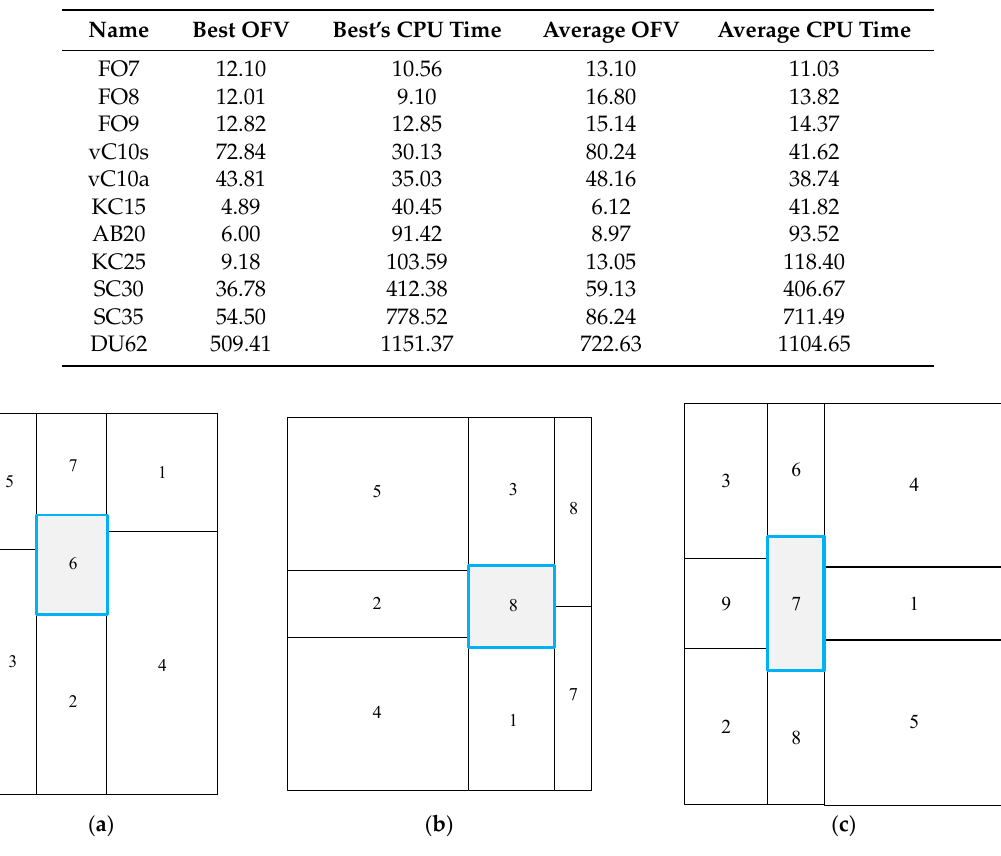
Figure 12. Layout configurations. ( a ) FO7; ( b ) FO8; ( c ) FO9.